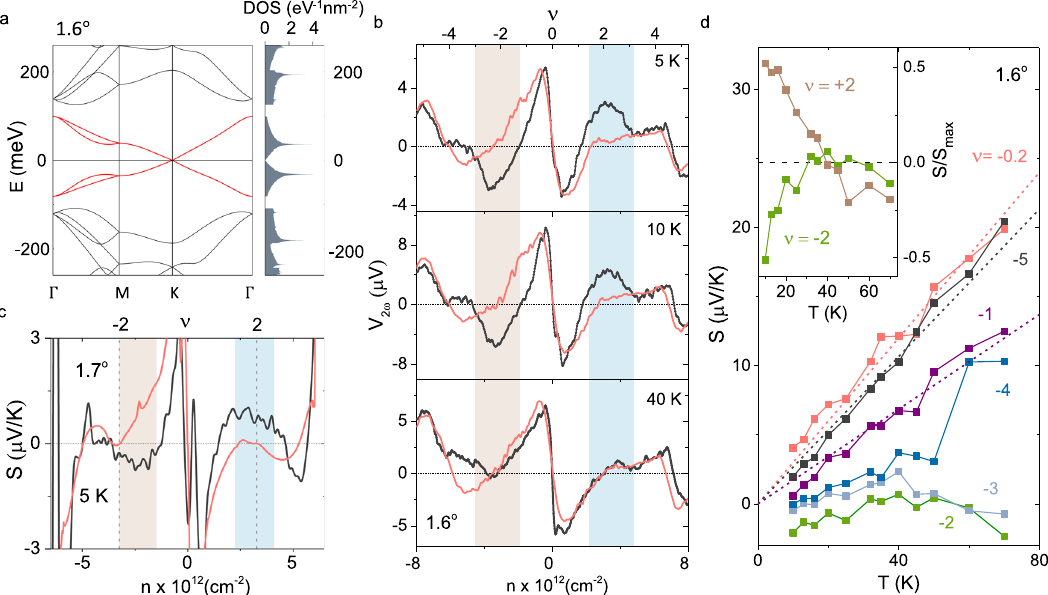
Fig. 3 Comparison with semiclassical Mott relation at ~ 1.6 ∘ . a Electronic band structure and density of states (DOS) of tBLG ( θ = 1. 6 ∘ ) calculated using tight binding model. The bands shown in red are the low energy active bands. b Comparison between the measured V 2 ω (black lines) and that calculated (orange line) from the semiclassical Mott relation (Eq. (2)) for θ ≈ 1. 6 ∘ at three representative temperatures. Δ T is obtained as a fi tting parameter to match SMR with the experimental V 2 ω at the CNP. c Doping dependence of S for θ ≈ 1. 7 ∘ compared to that of the SMR at 5 K. d Temperature dependence of S at various band fi lling factors. The dashed lines show the S ∝ T dependence. The inset shows the T dependence of S = S max at ν =